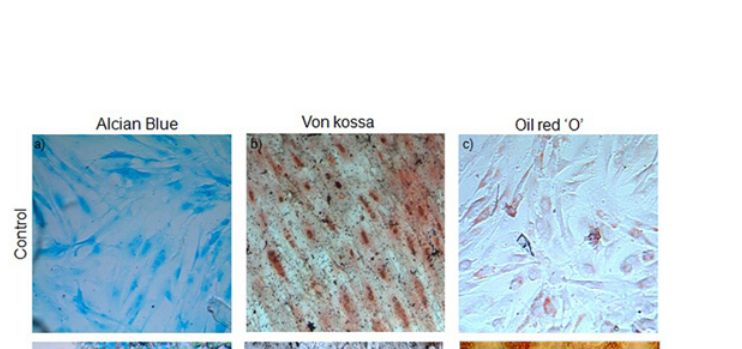
Fig 4. Bio-compatibility profiling of hADSCs on chitosan hydrogel. a) The results presented are the mean ± SD LDH levels detected in supernatants at different time intervals. LDH release was not detected for stem cells cultured on the hydrogel (n = 4, P < 0.05). b) MTT assay was used to represent cell metabolic activity and viability of hADSCs encapsulated in chitosan matrix for 7 days (mean ± SD, n = 3). c) Apoptosis assays demonstrated that the cells did not undergo apoptosis when cultured on hydrogel. In contrast, cells induced with H 2 O 2 underwent apoptosis (n = 3).